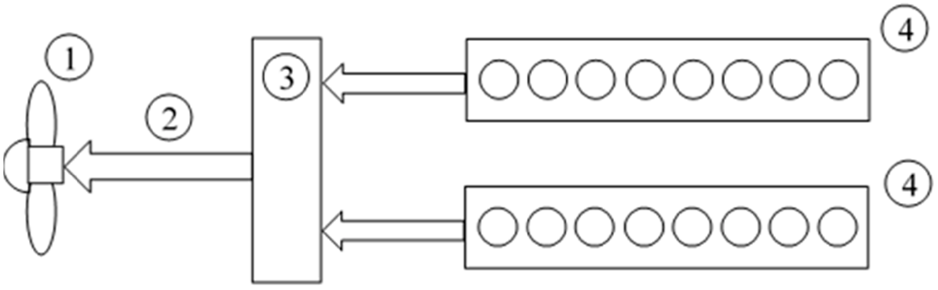
Figure 4. Propulsion by two low-speed diesel engines (Legend: 1—propeller, 2—propeller shaft, 3—gearbox, 4—two-stroke diesel engine).